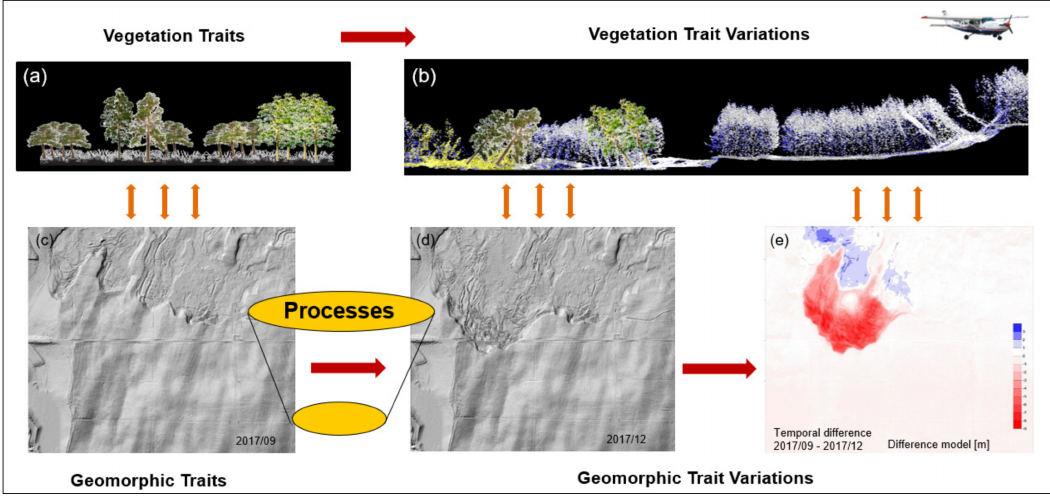
Figure 8. Changes in geomorphic traits lead to geomorphic trait variations. These changes can also lead to a change in vegetation traits, as geo- and biodiversity interact with each other either directly or indirectly. This example shows changes in geomorphology caused by underground open-cast mining with subsequent landslides. ( a ) Woody plants at the edge of a watercourse, ( b ) Overthrow of woody plants as a result of the collapse of underground open-cast mining tunnels and subsequent landslides, ( c ) Digital elevation model (DEM) recorded by airborne laserscanning (ALS) three months before the event (2017/09), ( d ) DEM recorded by ALS after the event (2017/12), ( e ) Difference model shows the geomorphological changes caused by the